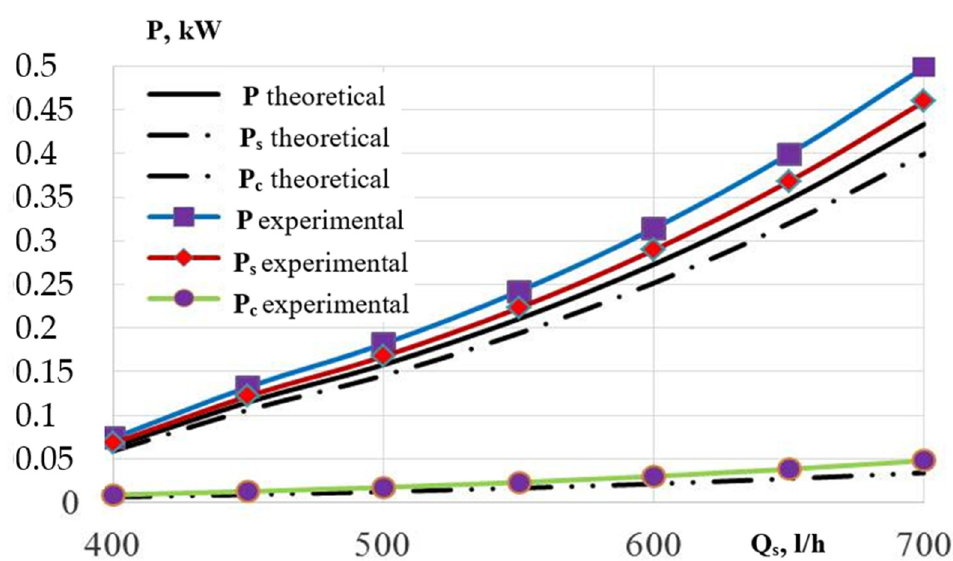
Figure 6. Graph of the dependence of the capacity of pumps for supplying skim milk, cream, and total capacity on the performance of the jet-slot milk total capacity on the performance of the jet-slot milk homogenizer.